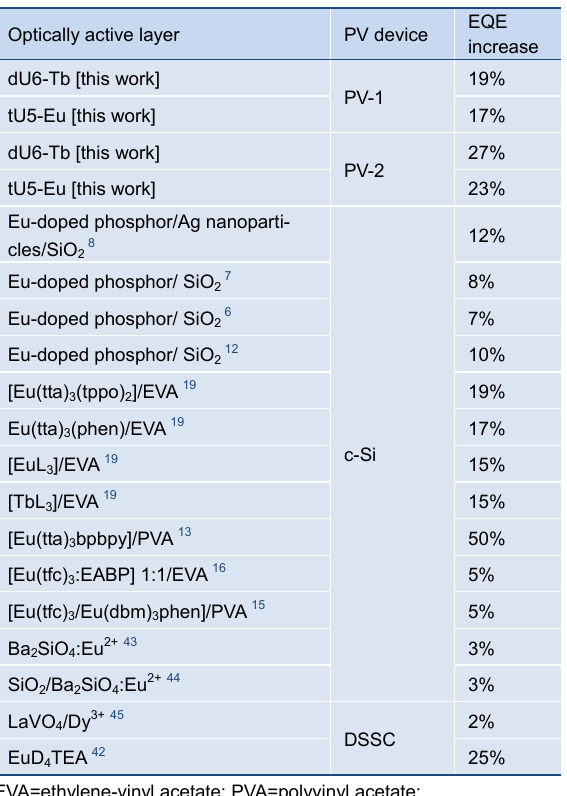
Fig. 6 | Scheme of the solar vehicle with (a) bare PV-2 and (b) PV-2 with the LDS coating and (c) photographs of the solar vehi- cles race. The solar vehicle with the coated PV cell is indicated by the red